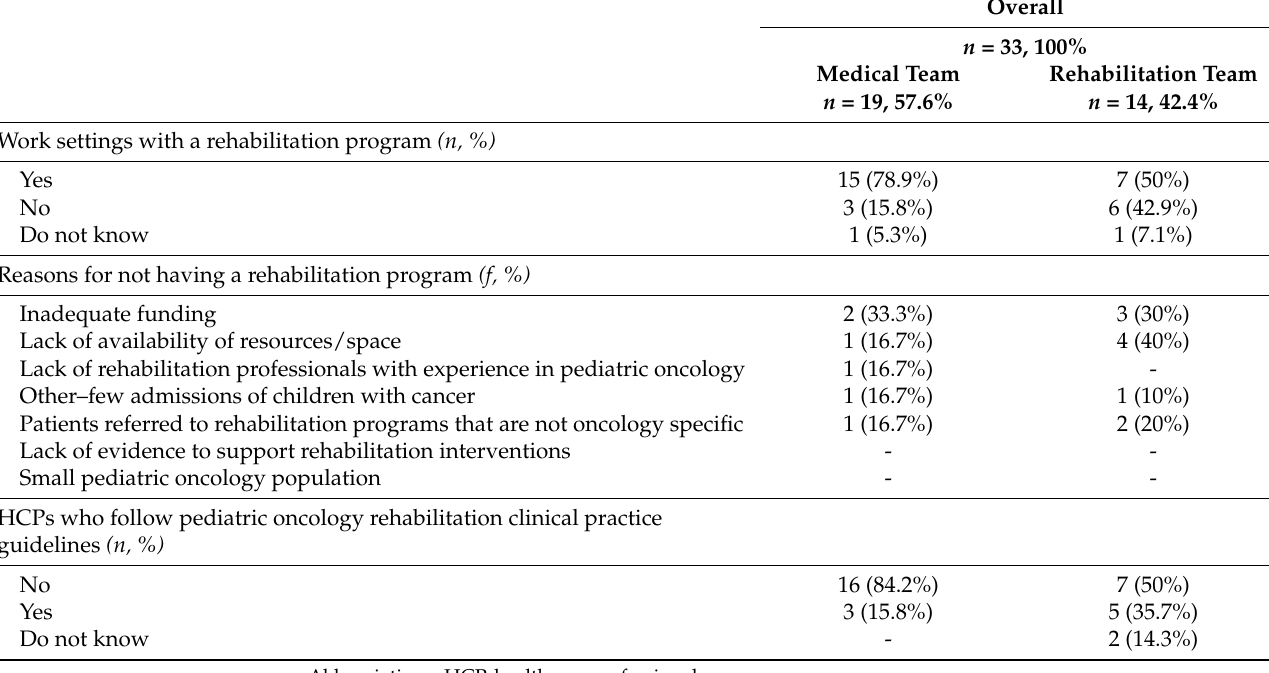
Table 4. Availability of rehabilitation programs and clinical practice